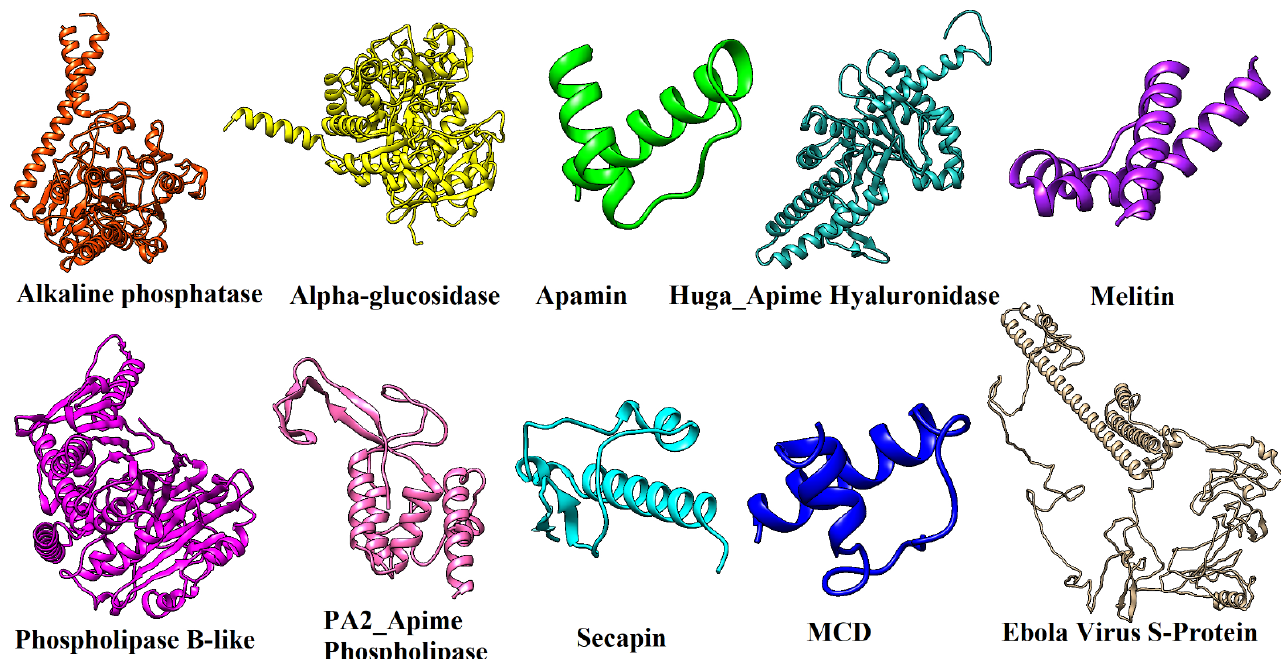
Figure 1. Three-dimensional models of normal Ebola viral spike protein and honeybee venom proteins .